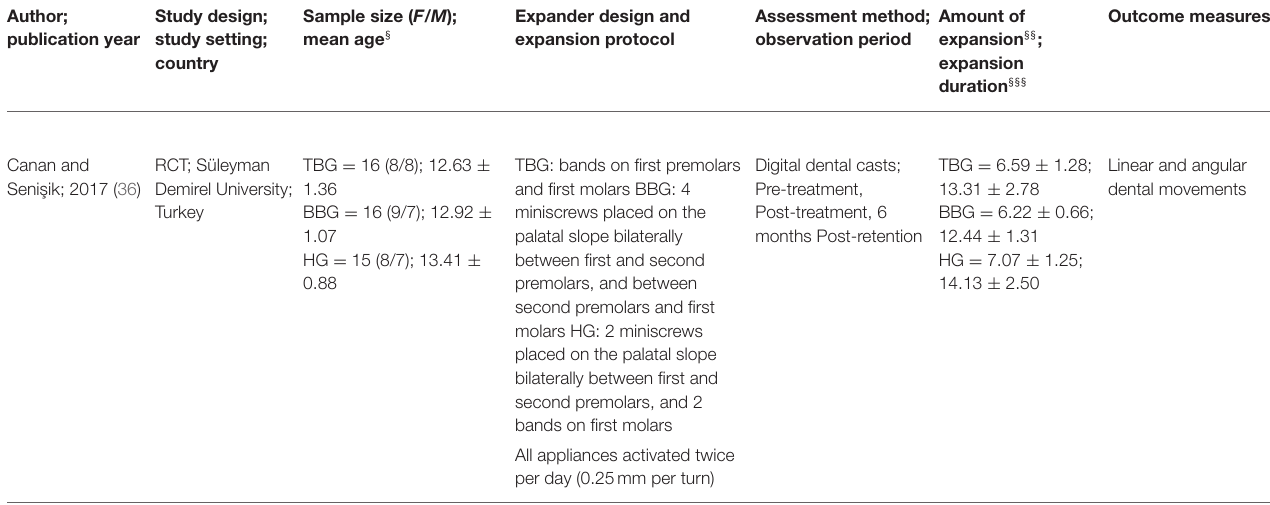
Sample size ( F / M ); mean age §